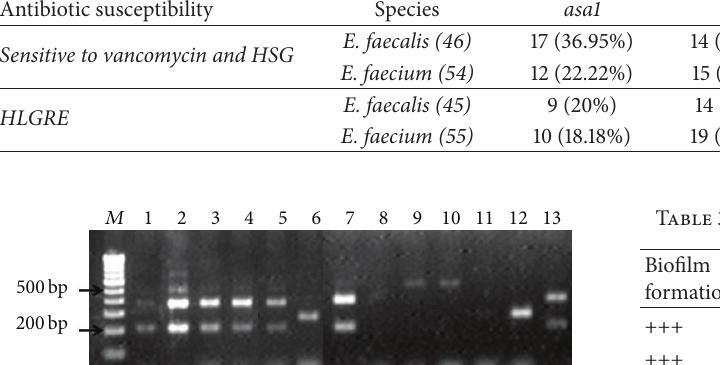
Table 2: Genotypic detection of virulence determinants in clinical isolates of enterococci. Antibiotic susceptibility